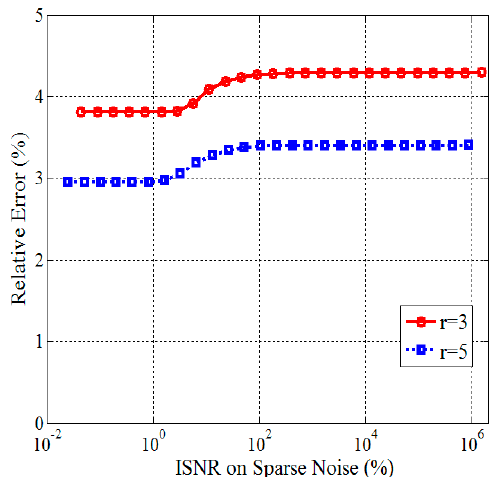
Figure 5. Relative errors versus different Inverse Signal-to-Noise Ratio (ISNR) on sparse noise.